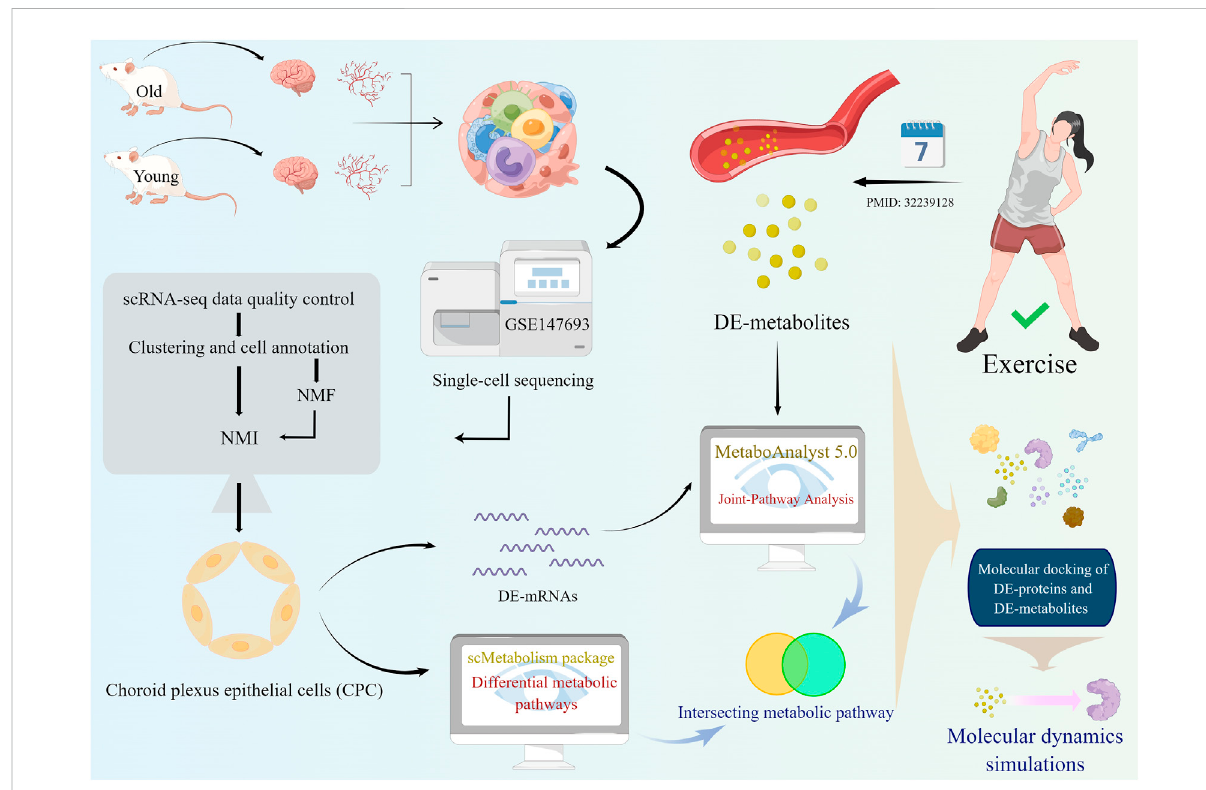
FIGURE 1 A schematic diagram showing the study fl ow. Firstly, single-cell analysis was performed on young and old mouse brain tissues from the GSE147693 dataset. Then the non-negative matrix factorization (NMF) method was used to measure heterogeneity between each pair of cells. Among the two types of glial cells in the CNS, astrocytes and choroid plexus epithelial cells (CPC), the heterogeneity of astrocytes changes more markedlywithageandthereareseveralinterestingintercellularinteractions.Age-relateddifferentialmetabolicpathwaysinCPCwereanalyzed and calculated using the scMetabolism package. Based on molecular dynamics simulations, oxidized glutathione targets CPC proteins that exhibit age